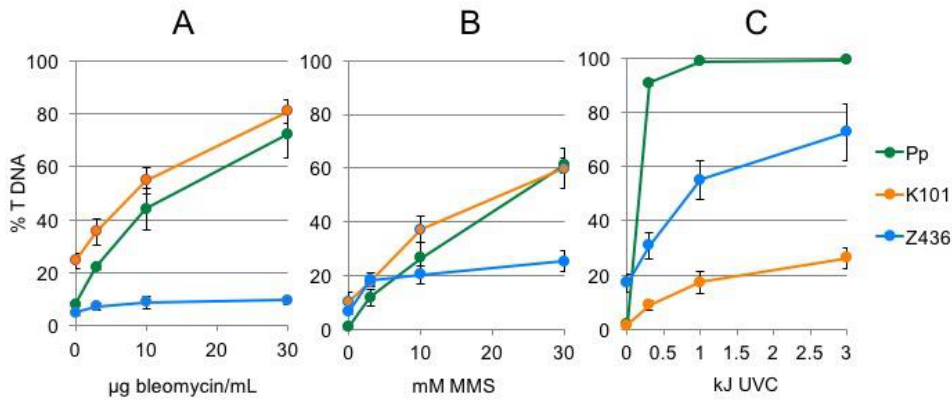
Figure 4. The dose-responses of algae and moss to genotoxic treatment. The suspension cultures of K. flaccidum K101, Zygnema sp. Z436 and Physcomitrella (Pp)were treated with 0–30 µ g/mL bleomycin ( A ) and 0–30 mM MMS for 1 h ( B ). The same cultures spotted on agar plates were irradiated with 0–3 kJ UVC ( C ). Upon treatment, the culture was blotted dry and immediately frozen in liquid nitrogen prior extraction of nuclei and analysis of DNA damage by the comet assay. The extent of DNA damage is indicated by the proportion of fragmented DNA in the ‘ comet tails ’ (% T DNA). Double strand breaks (DSBs) were followed as an end point of bleomycin treatment, single strand breaks (SSBs) as an endpoint of MMS treatment and DNA pyrimidine (CPDs) as an endpoint of UVC irradiation detected as T4EndoV sensitive sites.